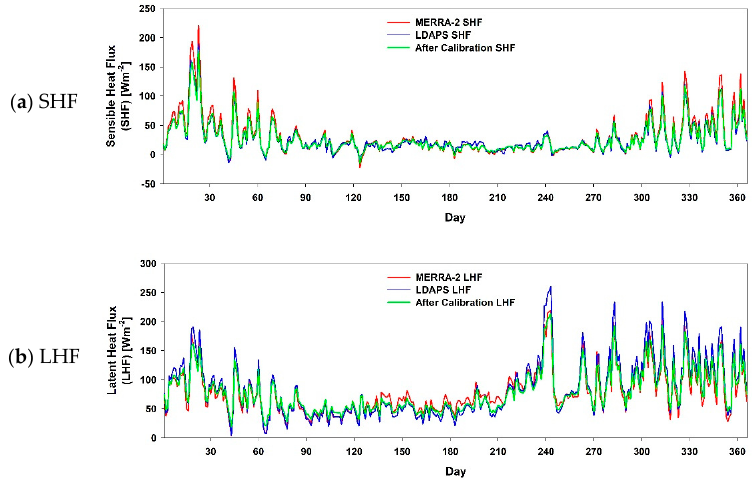
Figure 6. Daily mean ( a ) SHF and ( b ) LHF of MERRA-2 and LDAPS in 2016 before and after calibration.